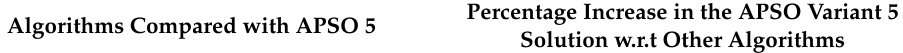
Table 12. Comparison of the APSO 5 solution with other algorithms solutions regarding percentage increase for the 500-PHEV dataset.